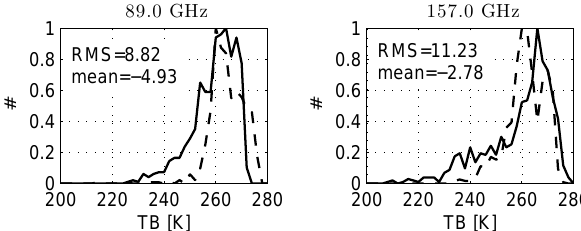
Figure 3. Histograms of the observed (solid line) and simulated (dashed line) MHS brightness temperatures at 89 and 157GHz with the Meso-NH microphysical scheme. The data used to calculate these distributions correspond to cloudy pixels (as determined my Meso-NH) over land as presented in Fig. 2. The rms and bias of the difference between the two are indicated for each